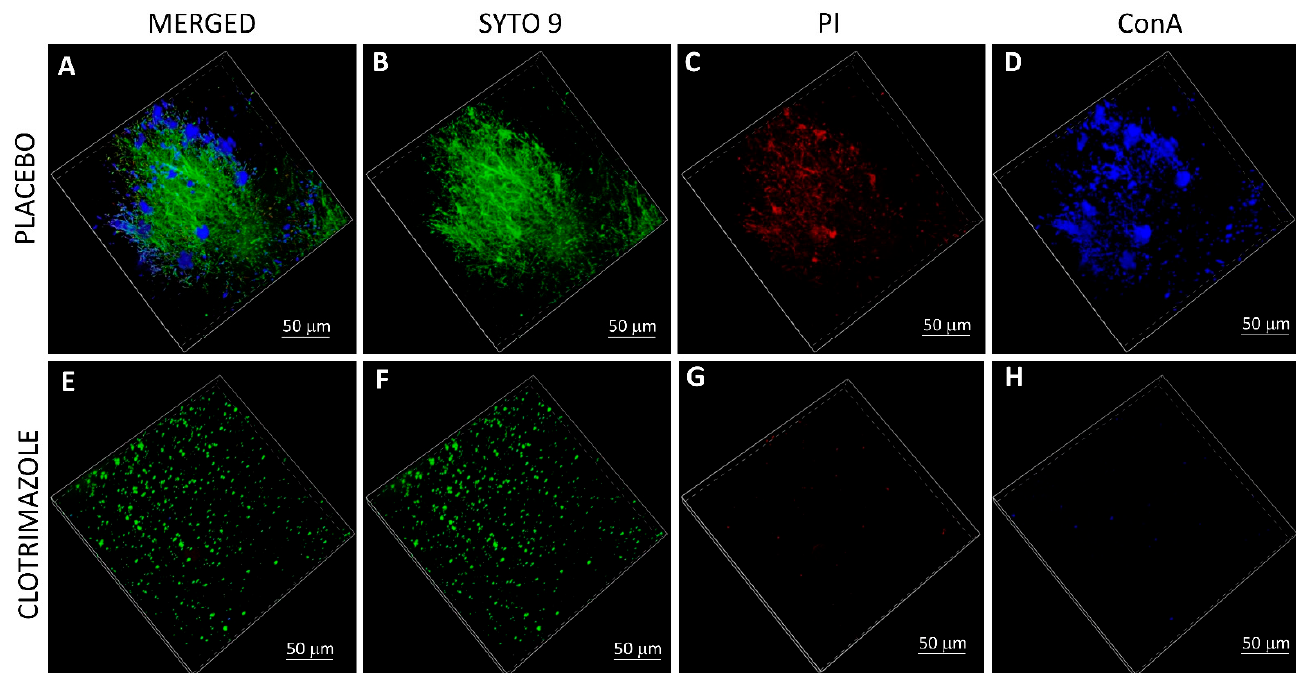
Figure 6. Scanning disk confocal microscopy (SDCM) of SRV-CTZ- versus placebo-coated VPs. SRV-CTZ- and placebo- coated VPs that have been daily incubated with fresh C. albicans cultures for 14 days were washed and stained with SYTO 9 (green fluorescence) ( B , F ), propidium iodide (PI, red fluorescence) ( C , G ) and AlexaFluor647-conjugated ConA (blue color) ( D , H ). The stained samples were visualized by a Nikon spinning disk confocal microscope. ( A , E ) are the merged images of the three staining dyes. ( A – D ) Placebo-coated VPs. ( E – H ) SRV-CTZ-coated VPs. N = 1.